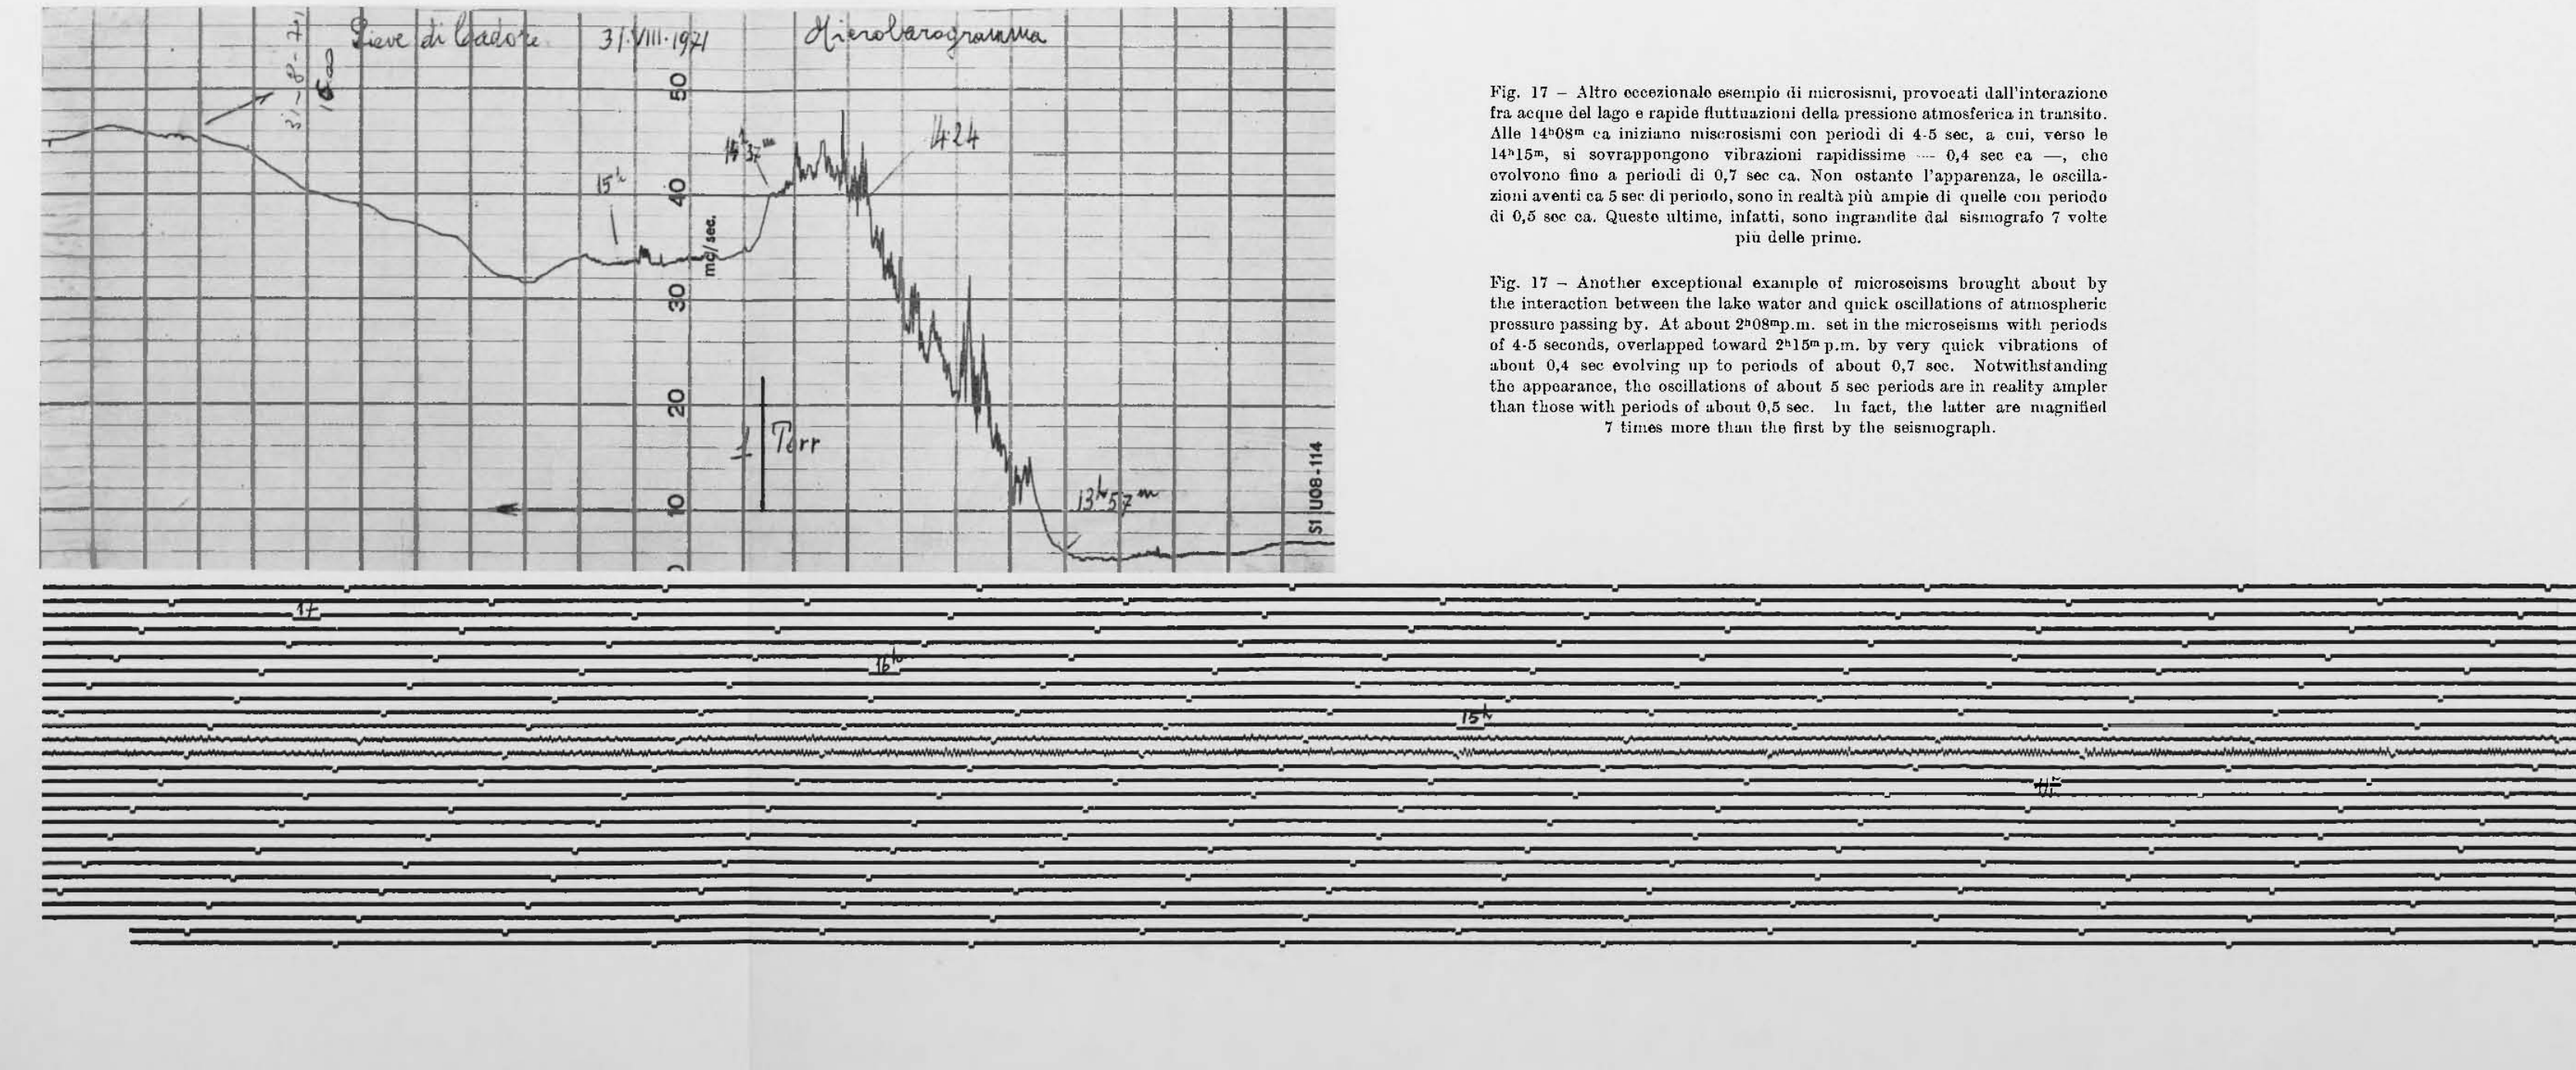
, I fm aC(lno del lago e rapide fluttuazioni della }Jressiono atmosIeriea in tnlollfsito. ,.1.." [4